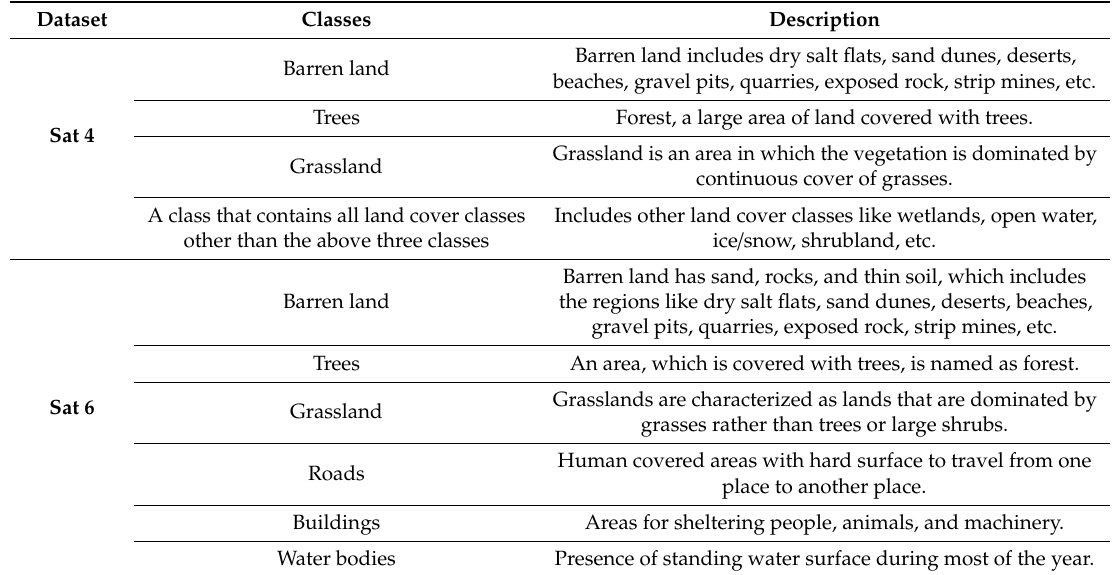
Table 1. Description of land-cover classes in Sat 4 and Sat 6 datasets.